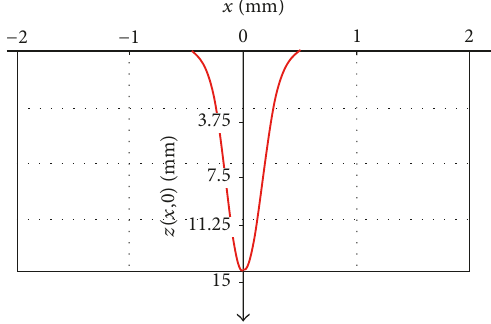
Figure 7: Cross-section of the penetration channel used for model-